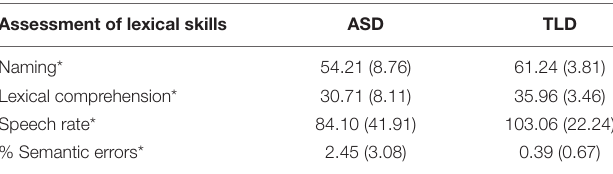
TABLE 2 | Results of the analysis of lexical skills in the groups of participants with ASD and TLD. Assessment of lexical